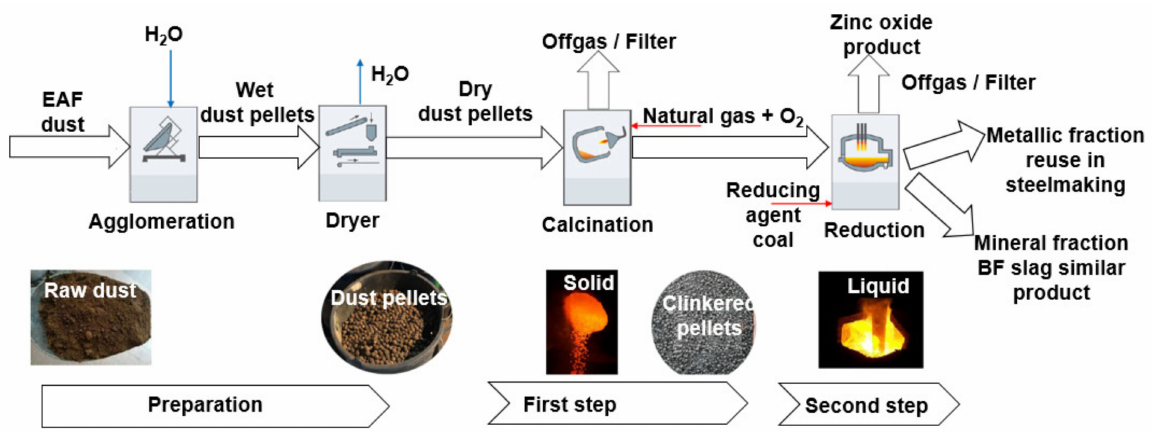
Figure 7. The 2sDR process steps that are used to take EAF dust from its raw state to the final products